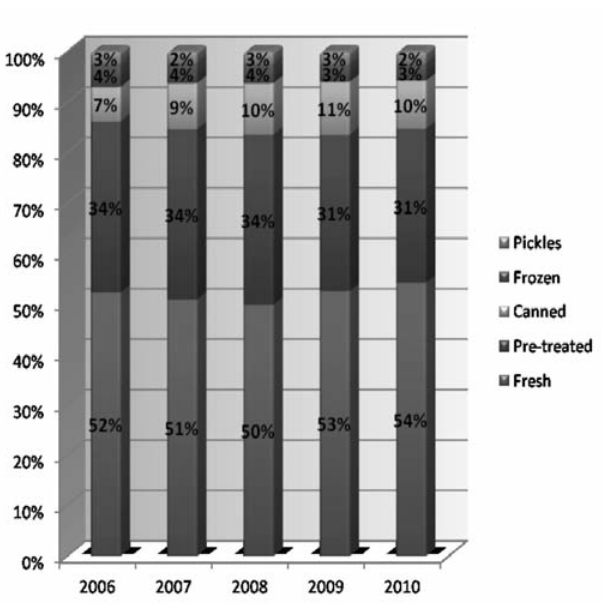
Figure 1. Supermarket Sales of vegetables (value) Source: PT / Nielsen